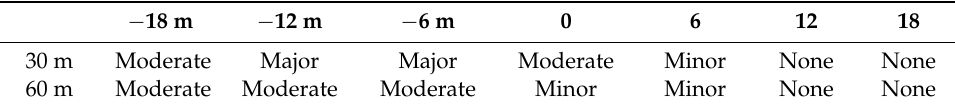
Table 3. Ground measurement patch inspection rating for exposure at each monitoring location during EFT.